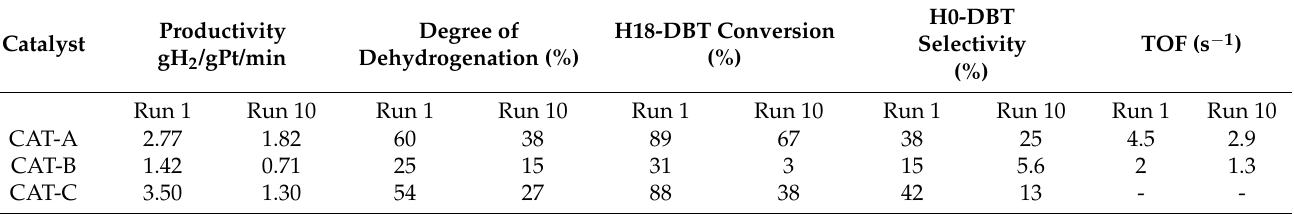
Table 1. Catalyst performance for the dehydrogenation of H18-DBT: summary. Reaction conditions: batch reactor, reaction time 100 min for each run, reaction temperature 300 ◦ C, catalyst Pt/Al 2 O 3